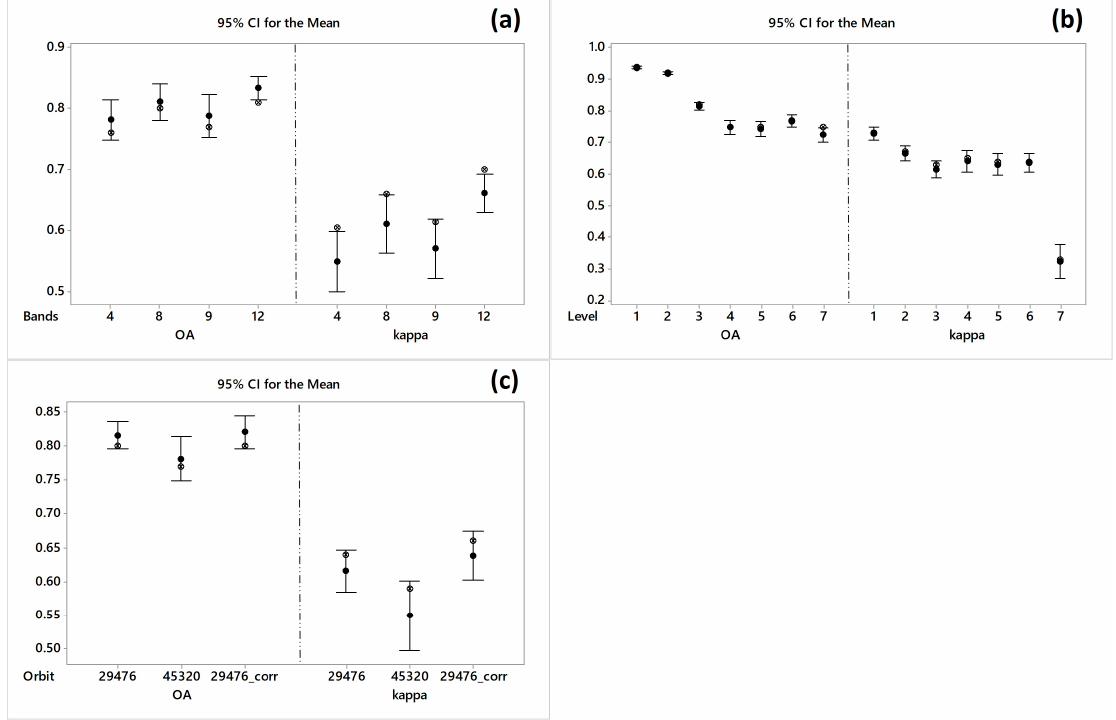
Figure 4. Interval plots from the pairwise post hoc test after applying the global approach variance analyses. ( a ) OA and kappa interval plots by bands; ( b ) OA and kappa interval plots by level; ( c ) OA and kappa interval plots by orbit. The circle with a cross inside represents the median values.